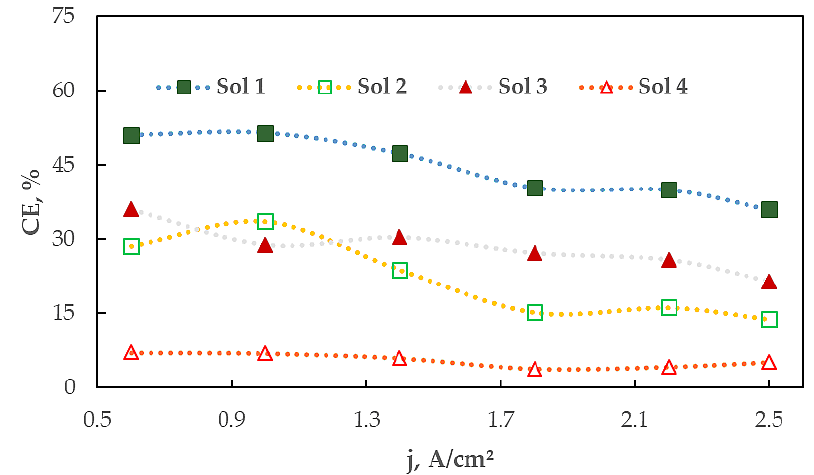
Figure 4. Influence of the cathodic current density on the current efficiency (CE) of Co coatings obtained under a galvanostatic mode and q = 180 C.